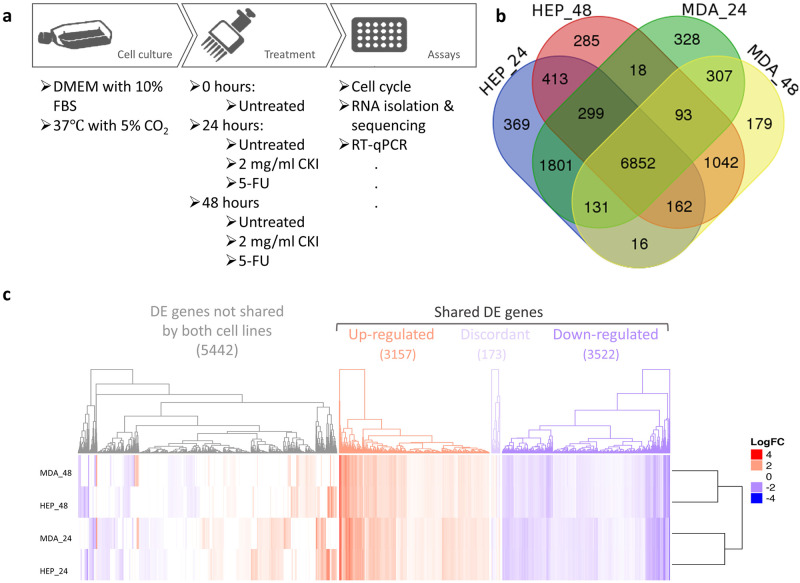
DE genes shared in both cell lines at both time points.a: Work flow diagram showing experimental design and sample collection. b: Venn diagram showing the number of shared DE genes between Hep G2 and MDA-MB-231. c: Heatmap presenting the overall gene expression pattern in both cell lines treated with CKI. Heatmap is split into four parts based on gene content and expression pattern: 5442 differentially regulated genes with expression not shared between the two cell lines, 3157 upregulated genes shared between both cell lines, 3522 down-regulated genes shared between both cell lines, and 173 discordantly regulated genes with differential expression shared between both cell lines.